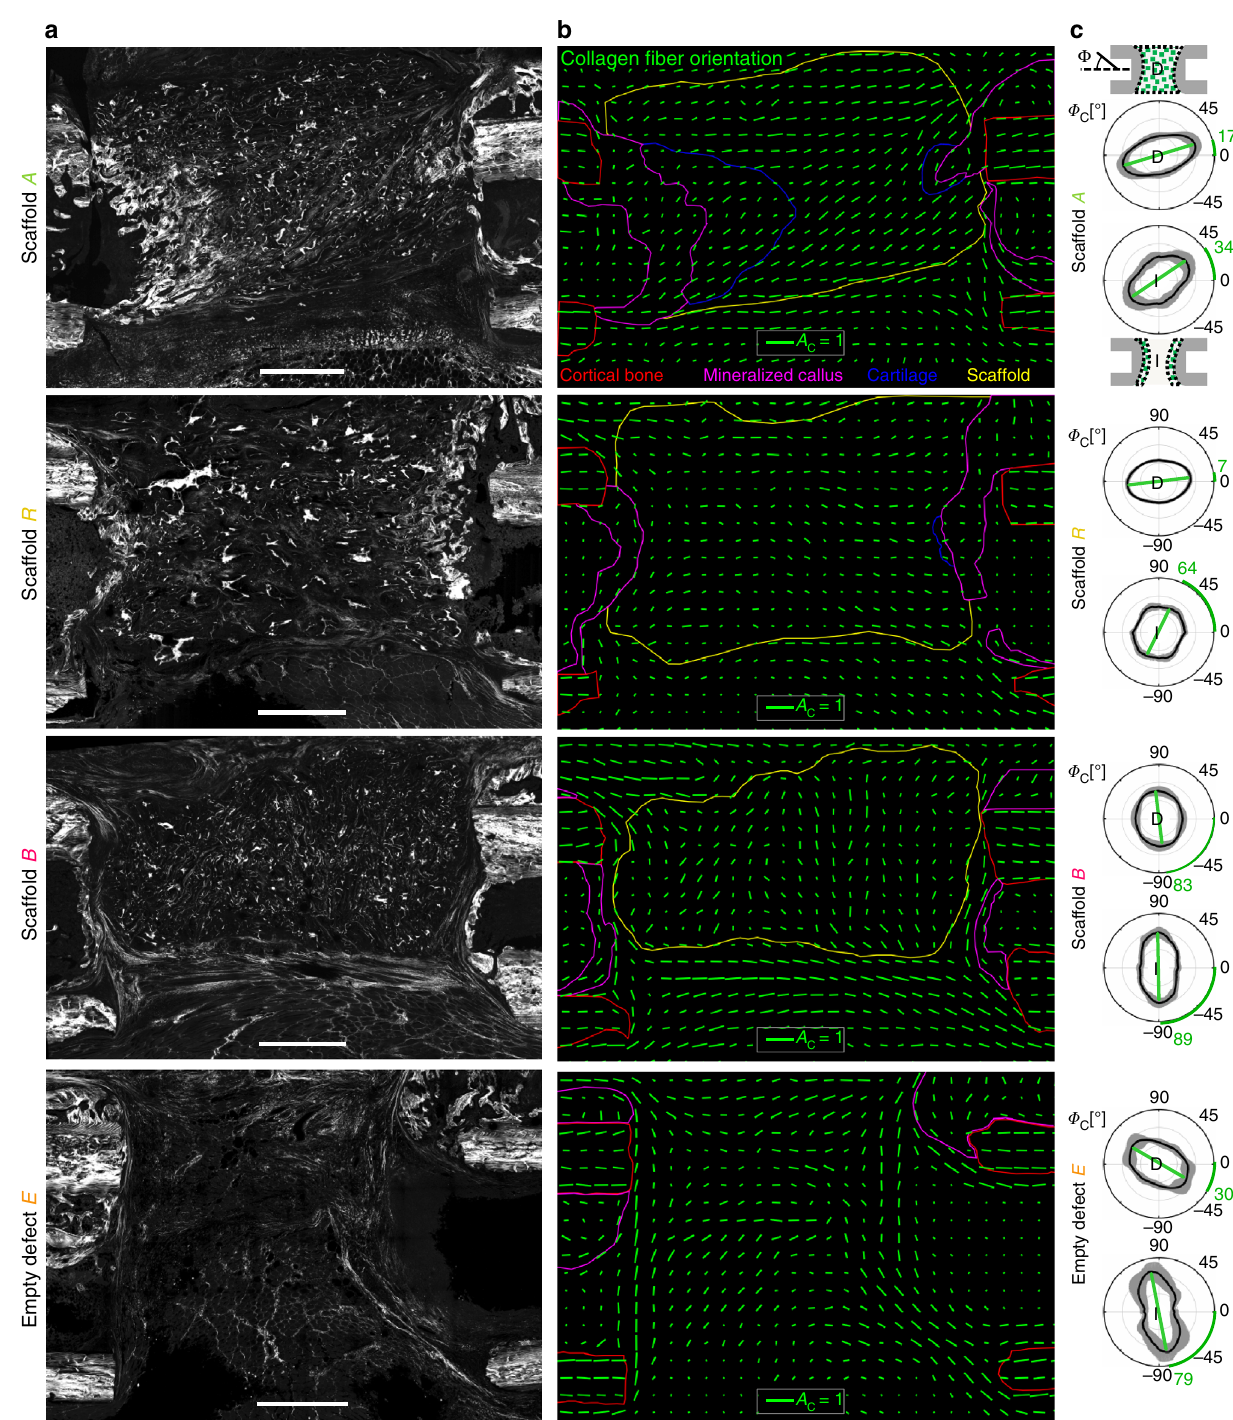
Fig. 4 Scaffold guides collagen fi bril alignment within the bone defect. a Representative SHG overview images of the bone defect 3 weeks post-op. b Analysis of local collagen fi ber anisotropy in the bone defect zone for representative animals of each group. Green lines indicate anisotropy A C (length of line) and direction of primary fi ber orientation Φ C (angle) within local ROIs of 200 µ m × 200 µ m size. Notice the pore orientation along the bone axis for scaffold A and perpendicular to the bone axis for scaffold B. Regions contoured by colored lines indicate cortical bone (red), mineralized callus matrix (magenta), scaffold (yellow), and cartilage (blue). c Distribution of collagen fi ber orientation Φ C within the scaffold (groups A, R, B) or within the empty bone defect (group E) is shown in diagrams labeled “ D ” . Polar plots show the distribution of orientation as mean values of all animals per group (bold line) and its SD (gray band). Bone axis is Φ C = 0°. The fi ber anisotropy can be read as the degree of polarization of the curve (long vs. short axis). Green lines and according green numbers indicate the angle of primary fi ber orientation. Analysis of the local fi ber orientation at the interface (diagrams labeled “ I ” ) reveal stability of orientation along the bone axis only in scaffold A, whereas orientation in all other groups is dominated by the interface itself with fi bers parallel to it and perpendicular to the bone axis (see also Fig. 1c). n = 5 – 7 animals for c . Scale bars for a 1 mm; b collagen fi ber anisotropy A C =